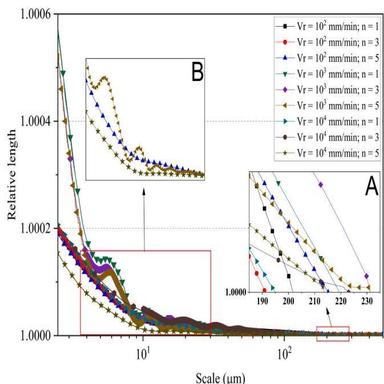
Scale-sensitive fractal analysis for distinct burnishing speeds and number of passes.